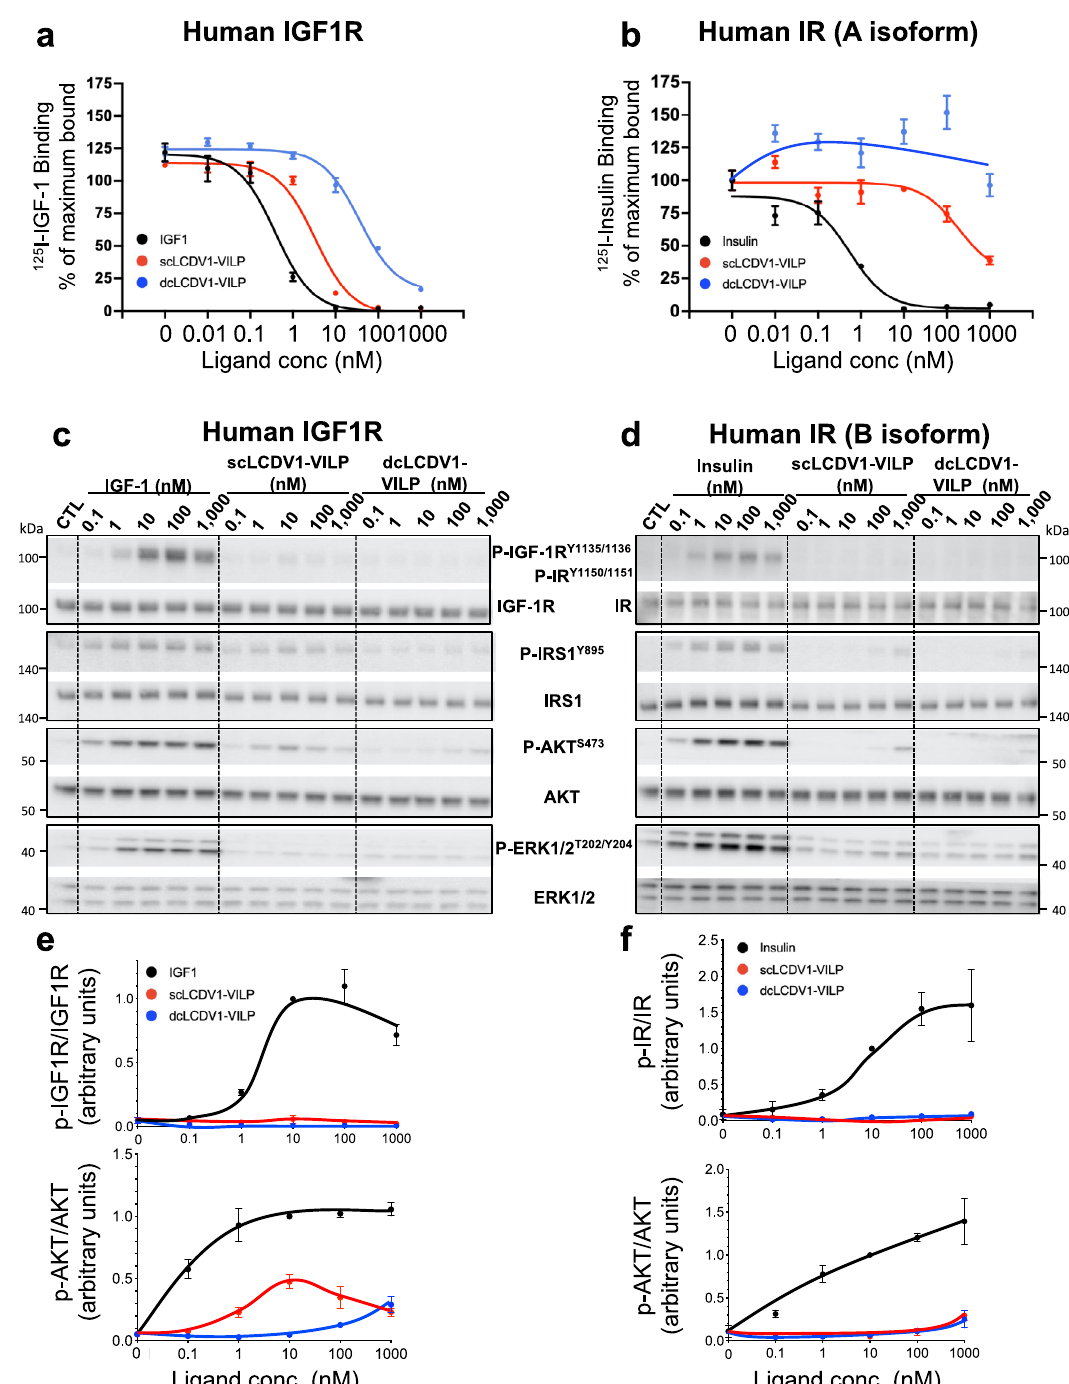
Fig. 2 | LCDV1-VILP as a single chain peptide is more potent to bind on IGF1R and on IR. Competition binding assays on human IGF1R ( a ) and human IR ( b ) ectodomains. Data are expressed as the mean±SEM, normalized to the baseline and expressed as % of the maximal binding of 125 I-IGF-1 ( a ) and 125 I-Insulin ( b ) incubated alone ( n =3 (IGF1R) and 4 (IR) independent wells). Western blot